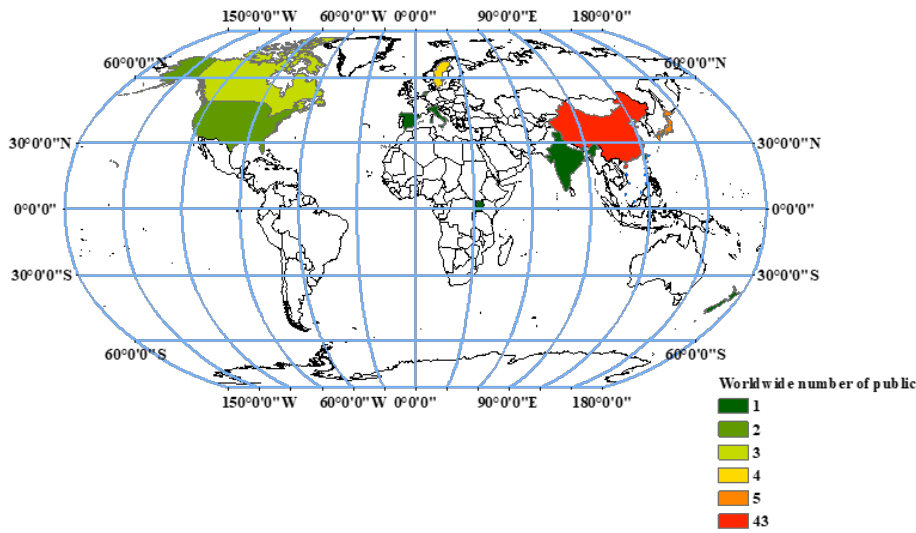
Figure 1. The distribution of publications used in meta-analysis related to GHG emission from CWs.